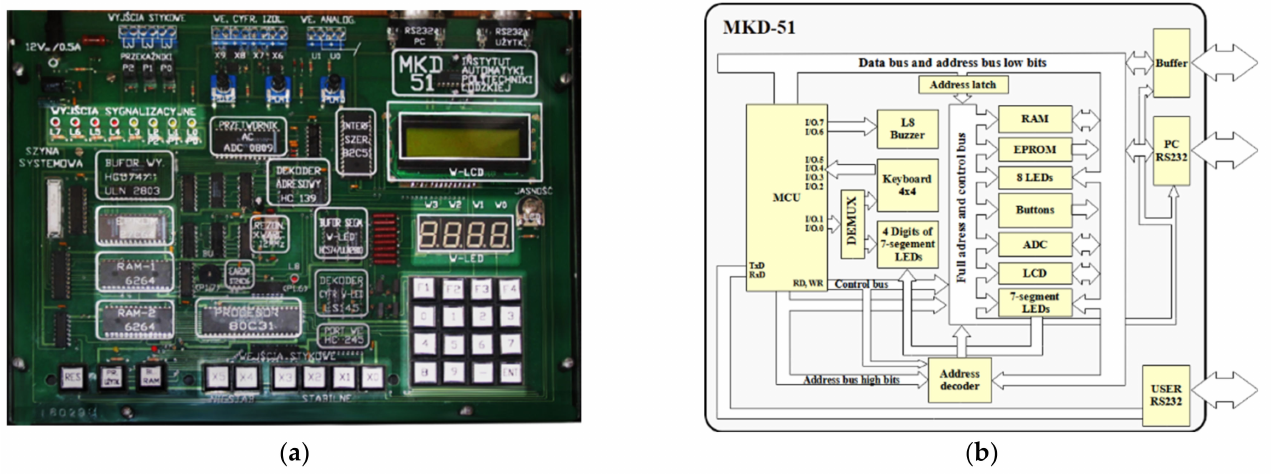
Figure 1. The MKD-51 didactic system: ( a ) real photo; ( b ) block diagram. All of those peripherals are handled both directly from MCU I/O ports and through an external bus, covering the basis of peripheral programming methods. The hardware struc- ture was intentionally left in a low scale of integration to show memories, address decoders, and additional I/O ports, gates, and buffers. Those are all of the electronic components that students should be aware of, especially given that every modern microcontroller [15] or Programmable System on Chip (PSoC) [16] has hidden them inside a single